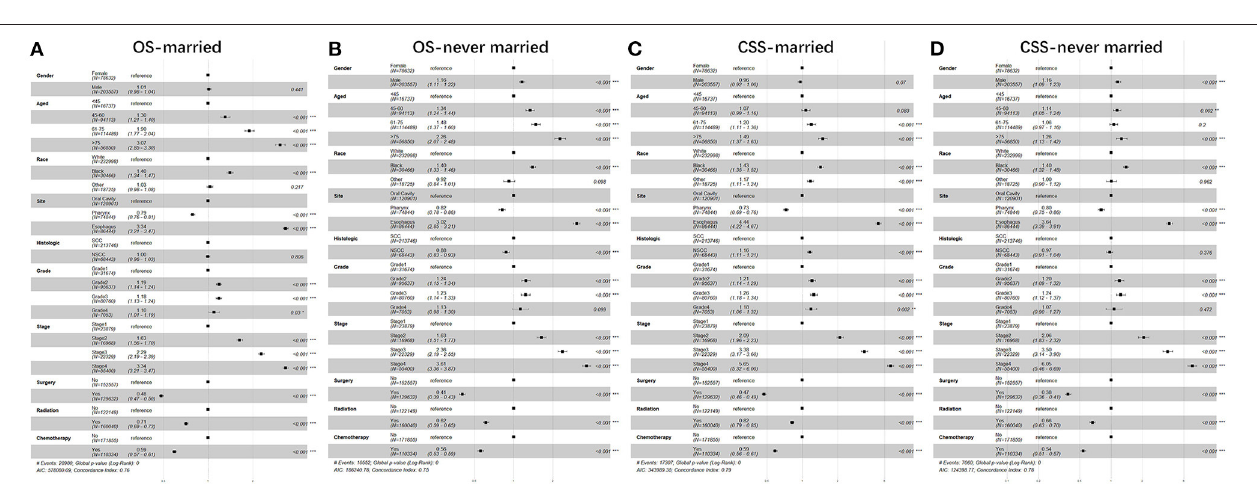
FIGURE 4 | The forest plot of HR (95% CI) for OS and CSS of the patients with UDTT in each gender. HR, hazard ratio; CI confidence interval; (A) OS of female; (B) OS of male; (C) CSS of female; (D) CSS of male.